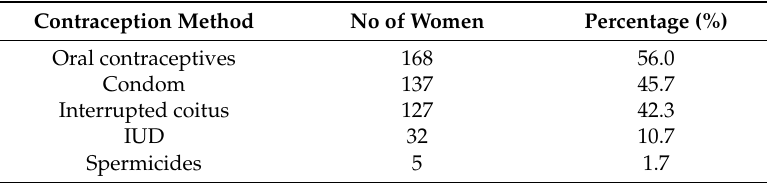
Table 2. Method of contraception in the study population.